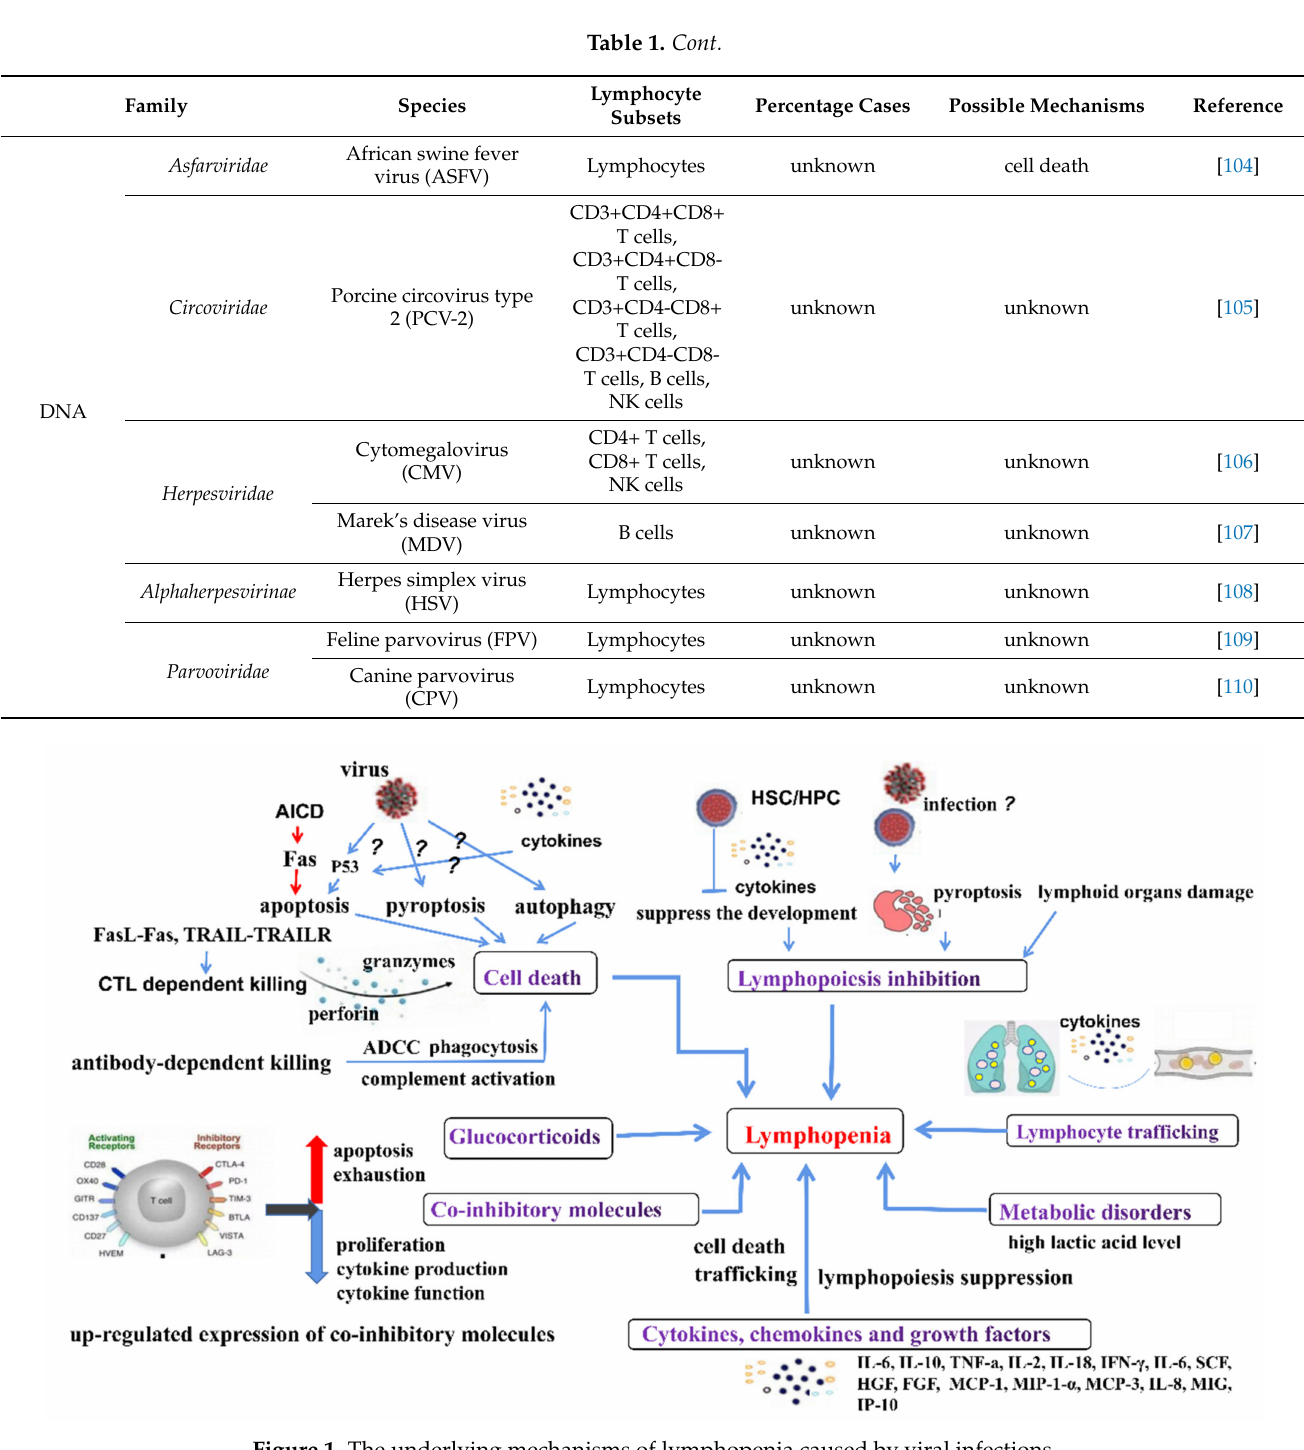
Figure 1. The underlying mechanisms of lymphopenia caused by viral